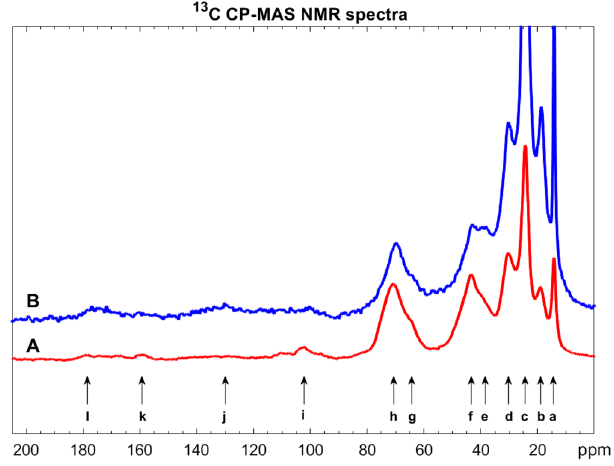
Figure 4. 13 C CP-MAS NMR spectra of sunflower (mark A, red curve) and rape (mark B, blue curve) sporopollenins treated by TBPH. The integral intensities of j, k aromatic carbon signals of p-coumaric groups and g, h O-aliphatic peaks were compared to each